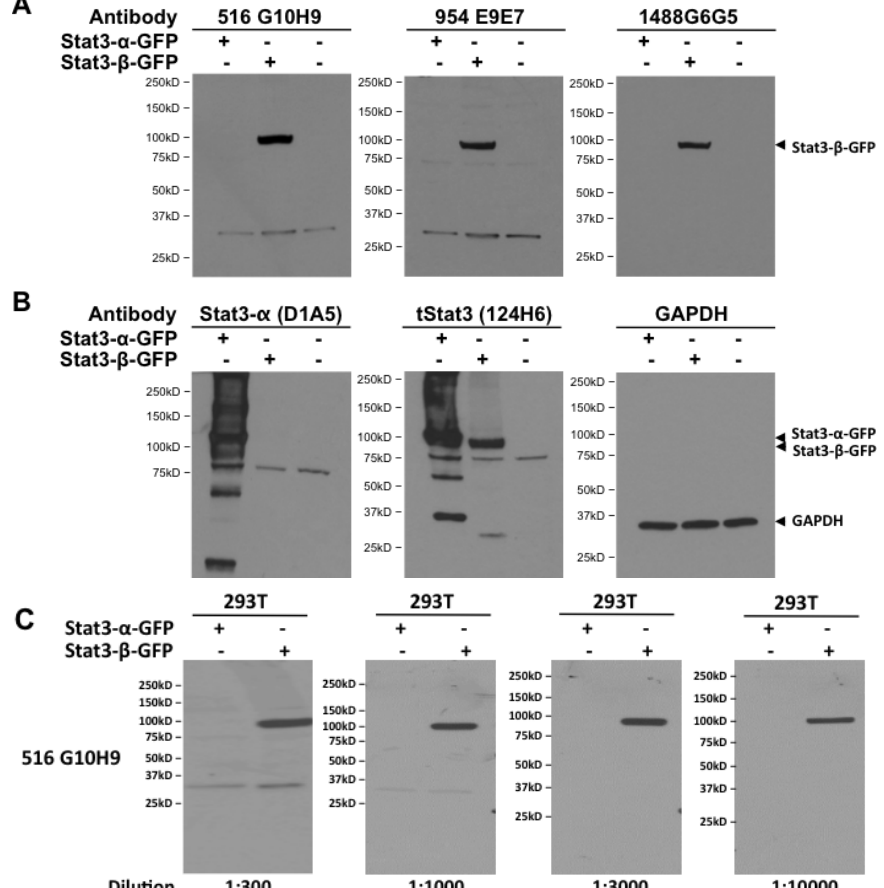
Figure 3. Stat3β monoclonals specifically detect Stat3β protein in cell protein extracts. Plasmids encoding fusion proteins Stat3α-GFP and Stat3β-GFP were transiently transfected into HEK 293T cells. Extracts (100 µg protein) from mock or plasmid transfected (48 h) cells were separated by SDS-PAGE, transferred to nitrocellulose membrane and replicate blots probed for ( A ) Stat3β using the three monoclonal antibodies 516 G10H9, 954 E9E7 and 1488 G6G5 and ( B ) Stat3α (Clone D1A5), total Stat3 (clone 124H6) and GAPDH and visualized by chemiluminiscence. Various dilutions (ranging from 1:300 to 1:10,000) of the three Stat3β monoclonal antibodies 516 G10H9 ( C ), 954 E9E7 ( D ) and 1488 G6G5 ( E ) were used to probe 100 µg protein from 293T cells transiently transfected with plasmids encoding fusion proteins Stat3α-GFP and Stat3β-GFP and visualized by